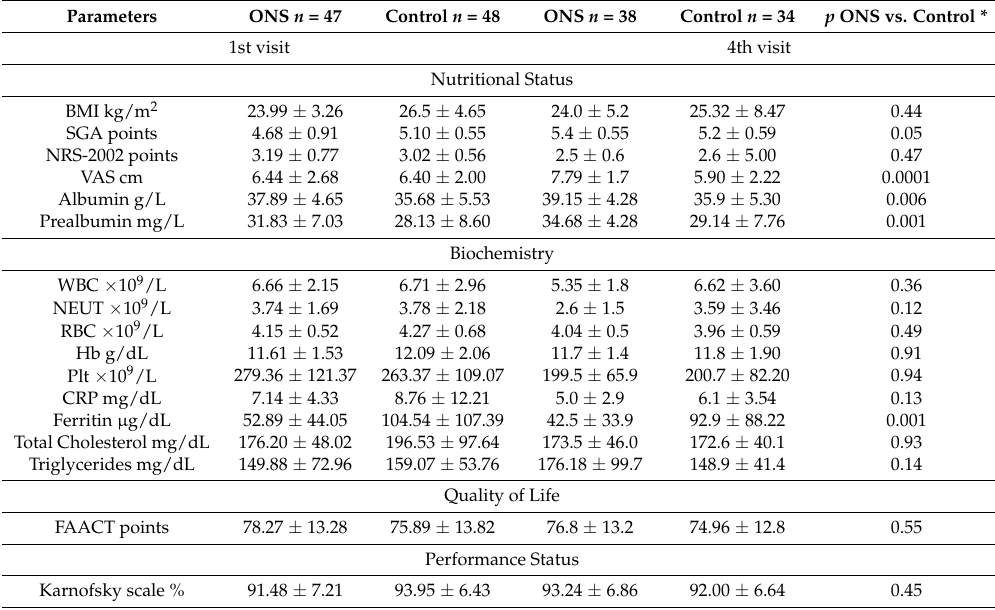
Table 2. The comparison between 1th and 4th visit in the study groups: ONS and Control. Parameters ONS n = 47